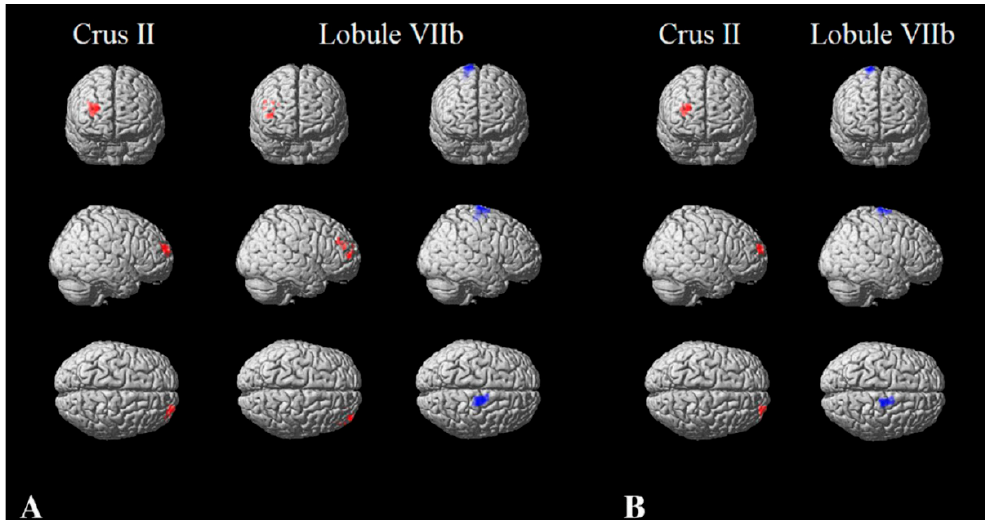
Figure 4. Cerebellar functional connectivity in multiple sclerosis. Cerebellar functional connectivity modification in patients with multiple sclerosis compared to controls, without taking into account ( A ) and after controlling ( B ) for cerebellar structural damage. Clusters of significant functional connectivity decrease are shown in red, while clusters of significant functional connectivity increase are presented in blue, superimposed on a standard 3D rendering of a brain volume in the Montreal Neurological Institute space. Reprinted from JOON , Vol. 265, Issue 10, P2260–2266, October 2018 [111]. Copyright: © 2021, with permission from Springer Nature.